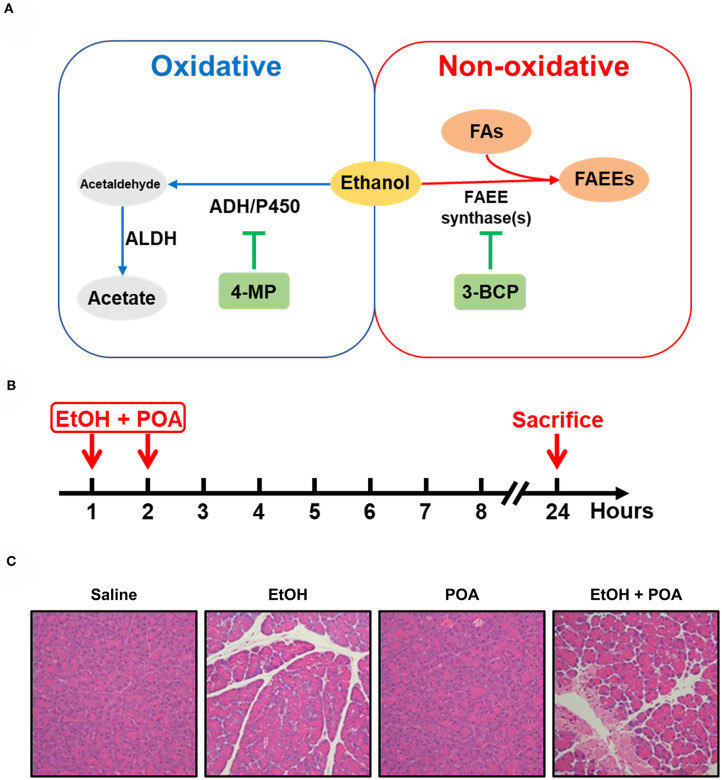
Ethanol metabolism and fatty acid ethyl ester-induced acute pancreatitis. (A) Non-oxidative and oxidative ethanol metabolism pathways. AHD, alcohol dehydrogenase; P450, cytochrome P450; ALDH, aldehyde dehydrogenase; 4-MP, 4-methylpyrazole; FAs, fatty acids; FAEEs, fatty acid ethyl esters; 3-BCP, 3-benzyl-6-chloro-2-pyrone. (B) A schematic of fatty acid ethyl ester-induced acute pancreatitis (FAEE-AP) in mice. The model was induced by concomitant administration of ethanol (1.35 g/kg) and palmitoleic acid (POA, 150 mg/kg). (C) Representative H&E images of pancreas histopathological slides of FAEE-AP (Huang et al., 2014).